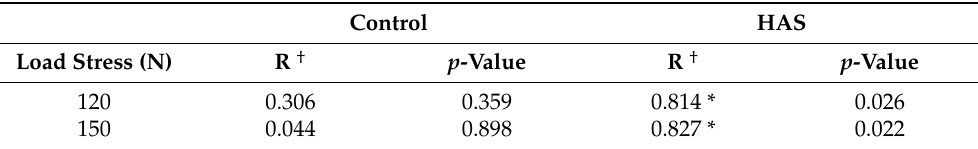
Table 2. Correlation between the anterior talar displacement during stress ultrasound and X-ray tests in the subjects with and without a history of ankle